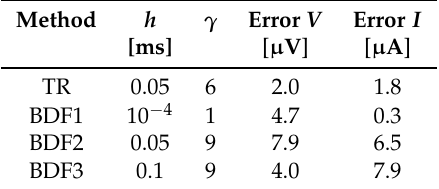
Table 15. Full wave rectifier: High-precision configuration of DAE integration